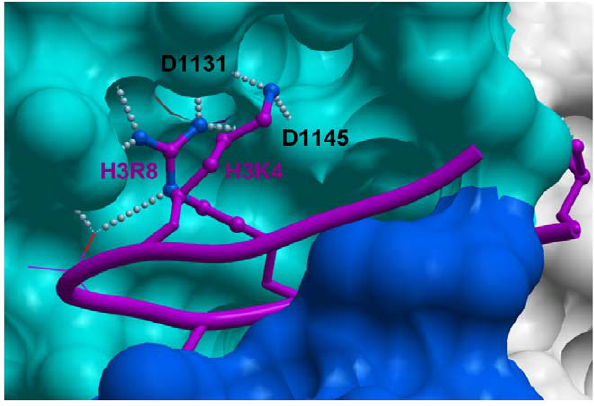
Figure 6. Contribution of H3K4 to H3K9 binding. Our structures of GLP in complex with H3K9me or H3K9me2 show that H3K4 folds on top of H3R8, making polar interactions with D1131 and D1145 of GLP.